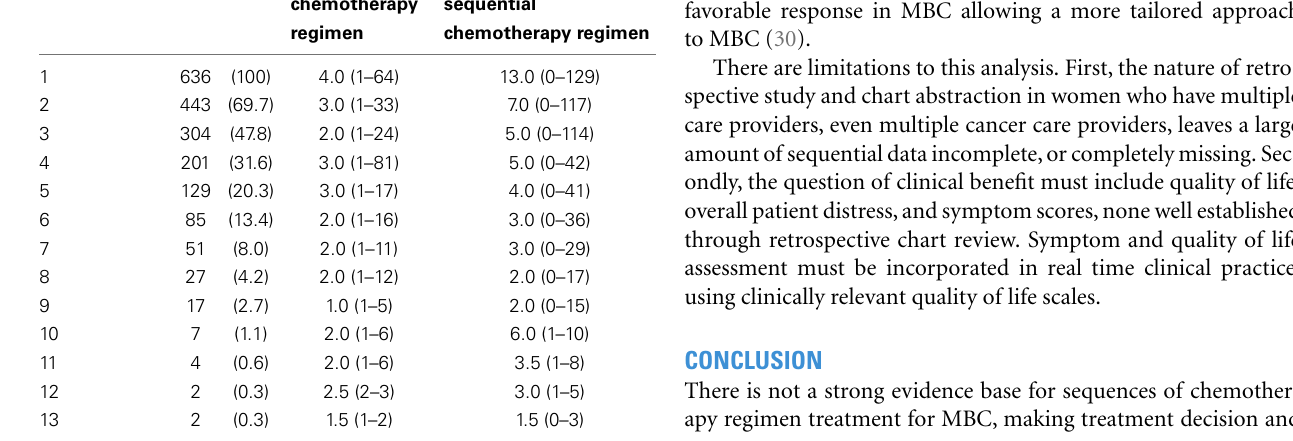
Table 3 | Median months of sequential chemotherapy regimen and survival from completion of sequential treatment, stratified by ER/PR status. Sequence of chemotherapy regimen